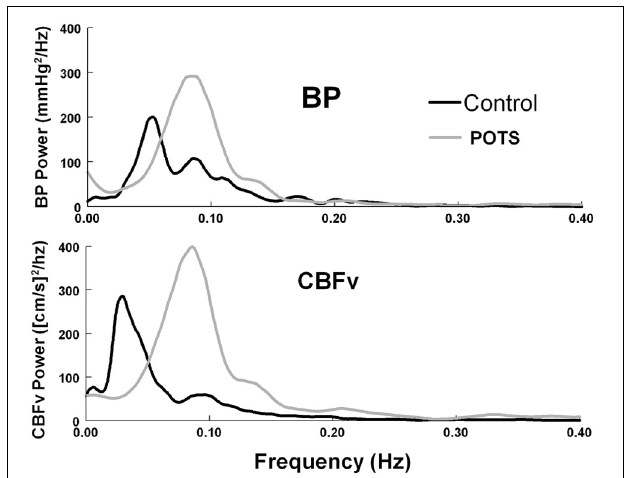
FIGURE 2 | Autospectral curves showing mean arterial pressure (BP) power and cerebral blood flow velocity (CBF v ) power, comparing control subjects to POTS patients while upright. There is a significant shift to higher frequencies in POTS patients ( p < 0 . 01).